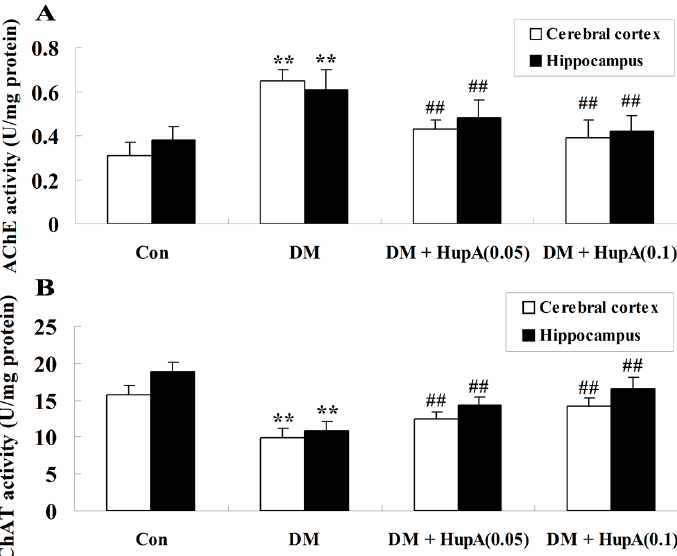
Figure 4. Effects of HupA on the activities of AChE ( A ) and ChAT ( B ) in cerebral cortex and hippocampus of control and diabetic rats ( n = 8, mean ± S.D.). ** p < 0.01 compared with Con group; ## p < 0.01 compared with DM group. Con, control; DM, diabetes; DM + HupA (0.05), huperzine A (0.05 mg/kg)-treated; DM + HupA (0.1), huperzine A (0.1 mg/kg)-treated groups.